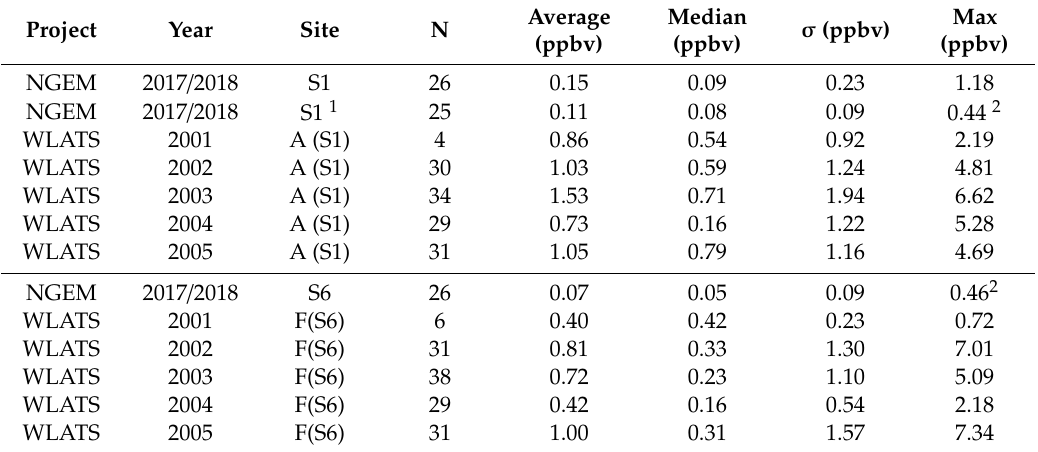
Table 1. Comparison of 1,3-butadiene PS results from this project with approximate WLATS